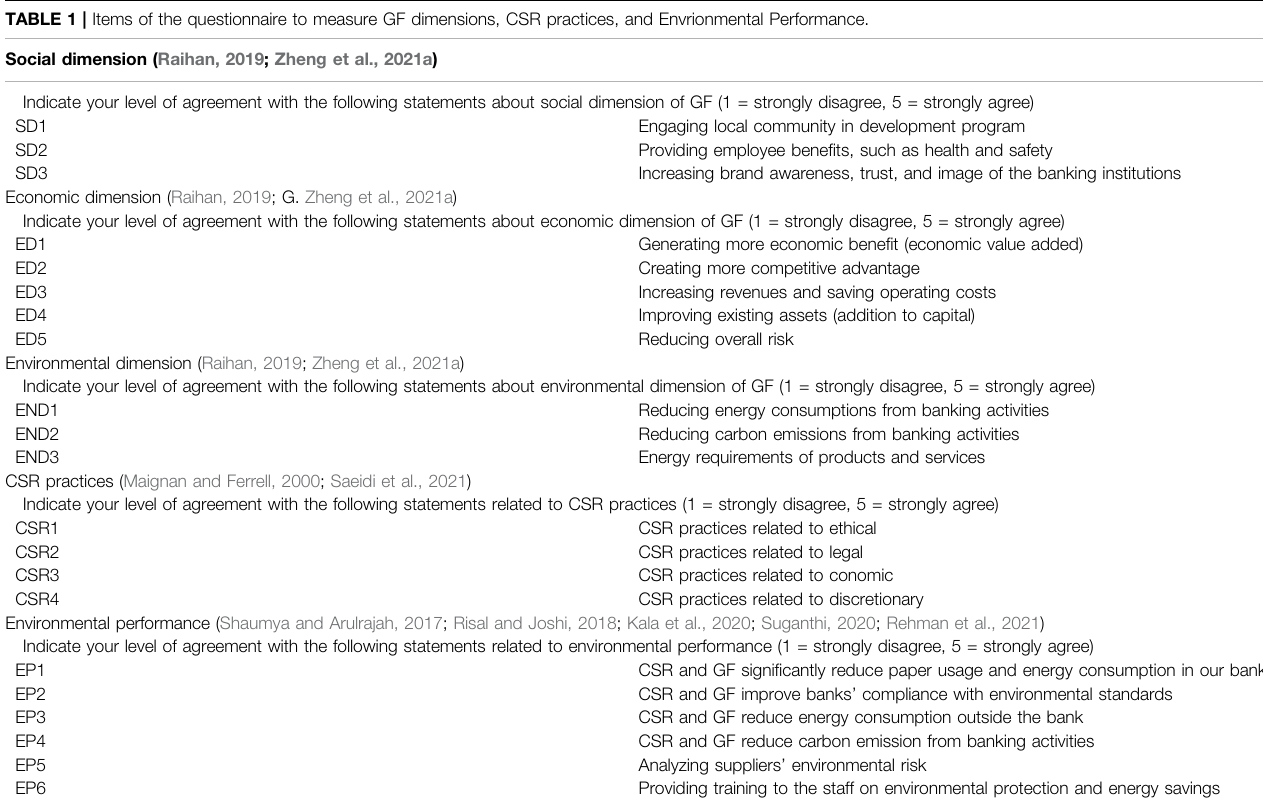
TABLE 1 | Items of the questionnaire to measure GF dimensions, CSR practices, and Envrionmental Performance. Social dimension (Raihan, 2019; Zheng et al.,